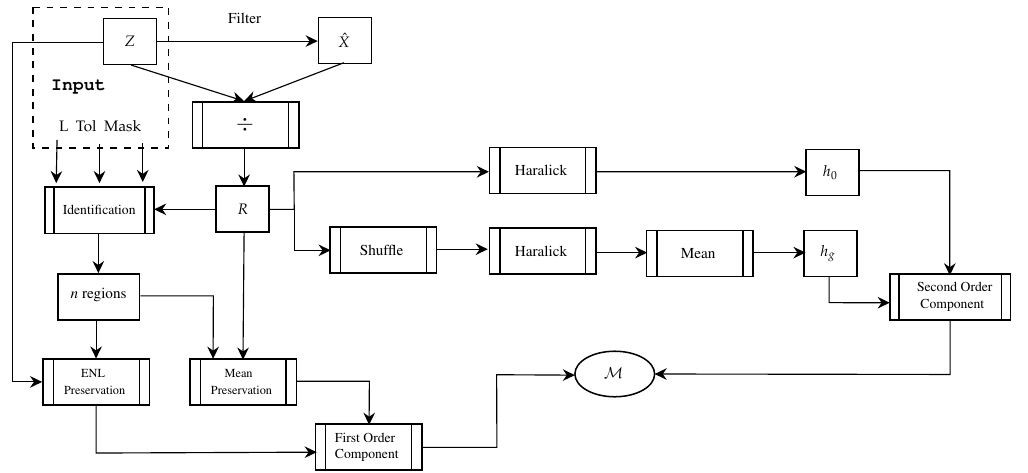
Figure 1. Schematic representation of the steps for computing the